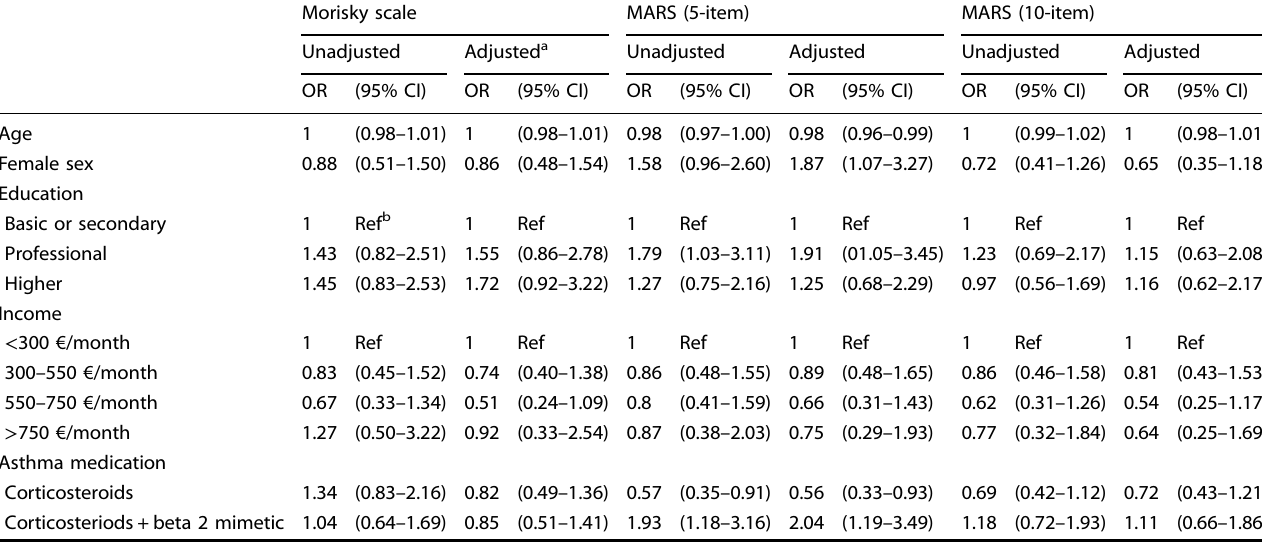
Table 3. Associations of socio-demographic and socio-economic factors with poor treatment adherence in asthma patients Morisky